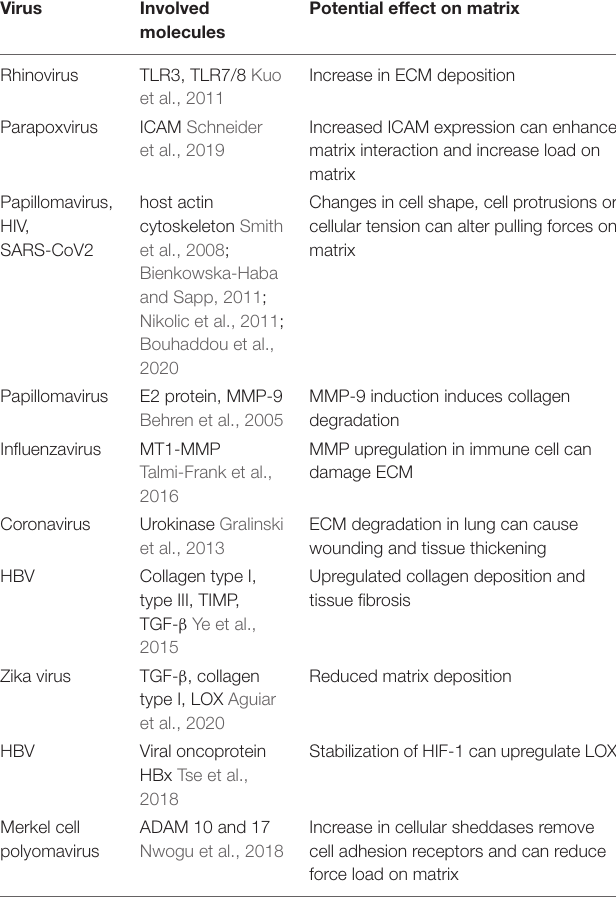
TABLE 3 | Viruses can modify the quantity and quality of the ECM directly and